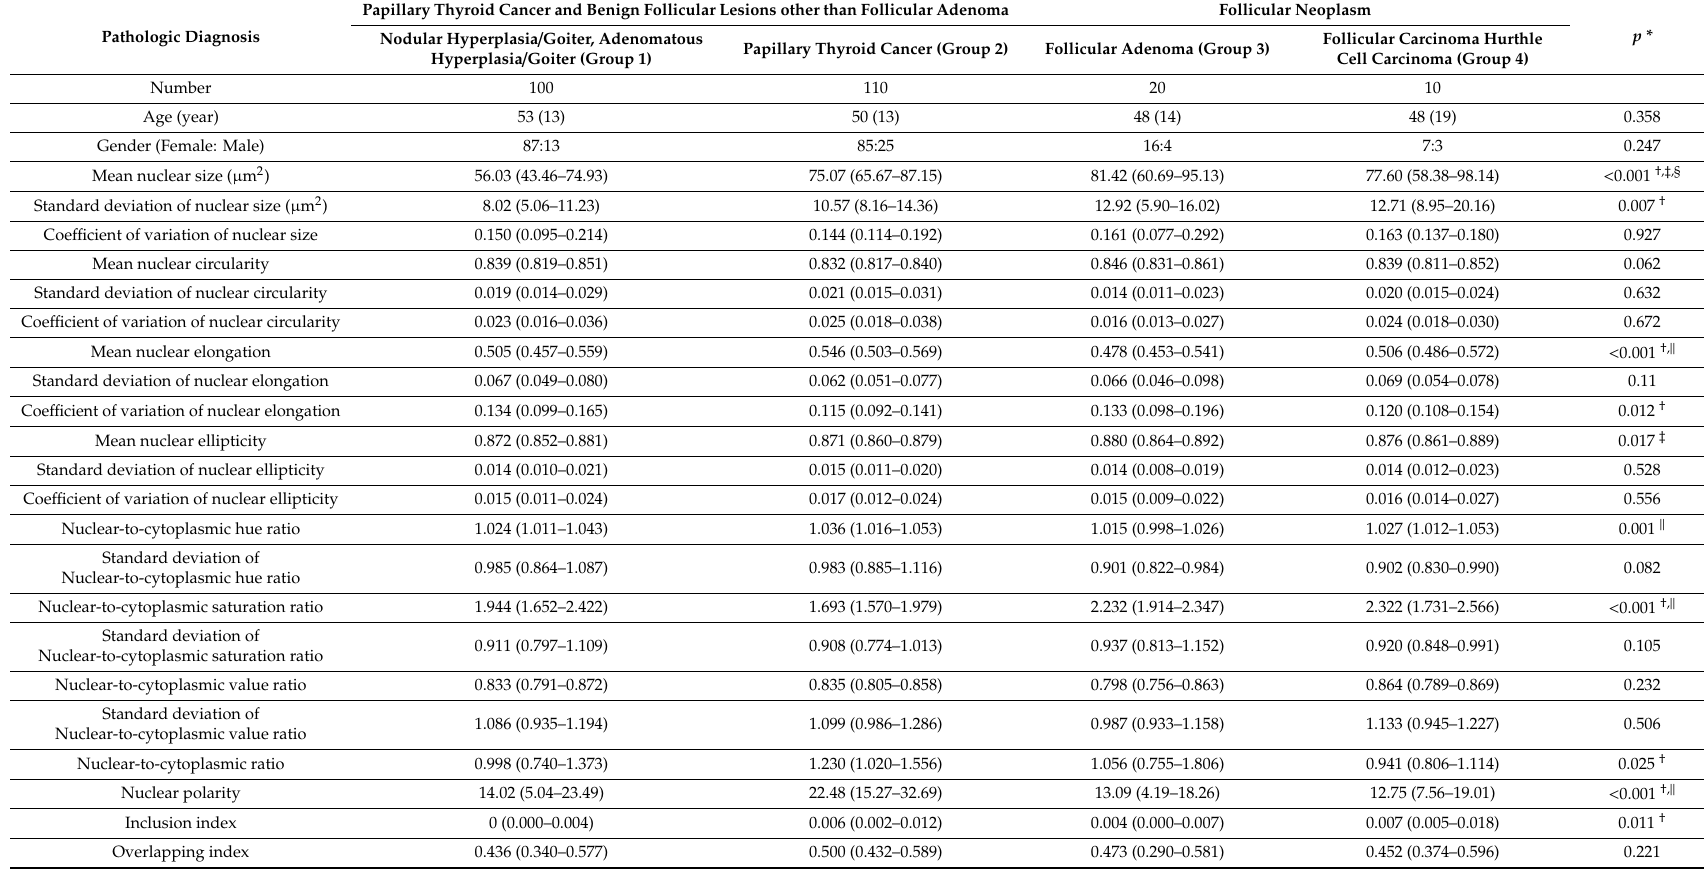
Table 2. Cytomorphometry of fine needle aspiration specimens in di ff erent pathologic diagnosis. Pathologic